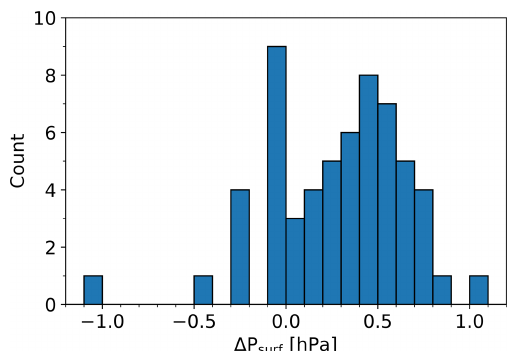
Figure 26. Histogram for the surface pressure difference (RS92 mi- nus barometer